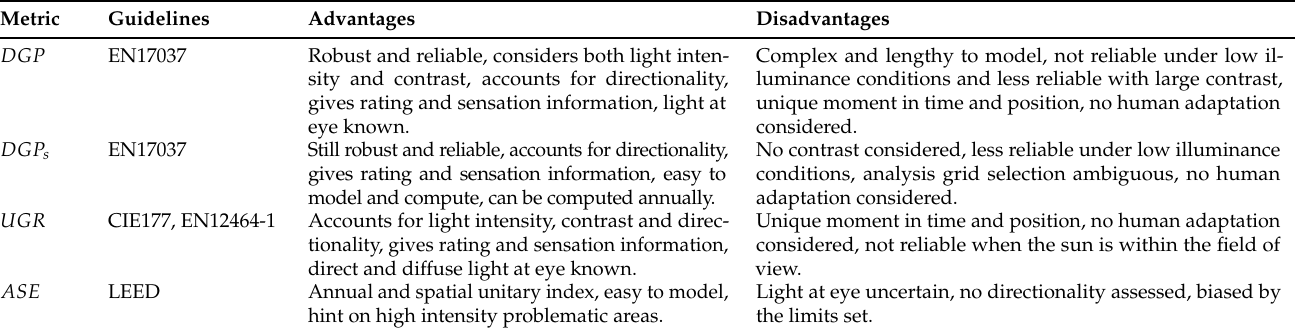
Table 3. Critical analysis summary of collected visual discomfort condition metrics based on daylight intensity and directionality, highlighting their benefits and